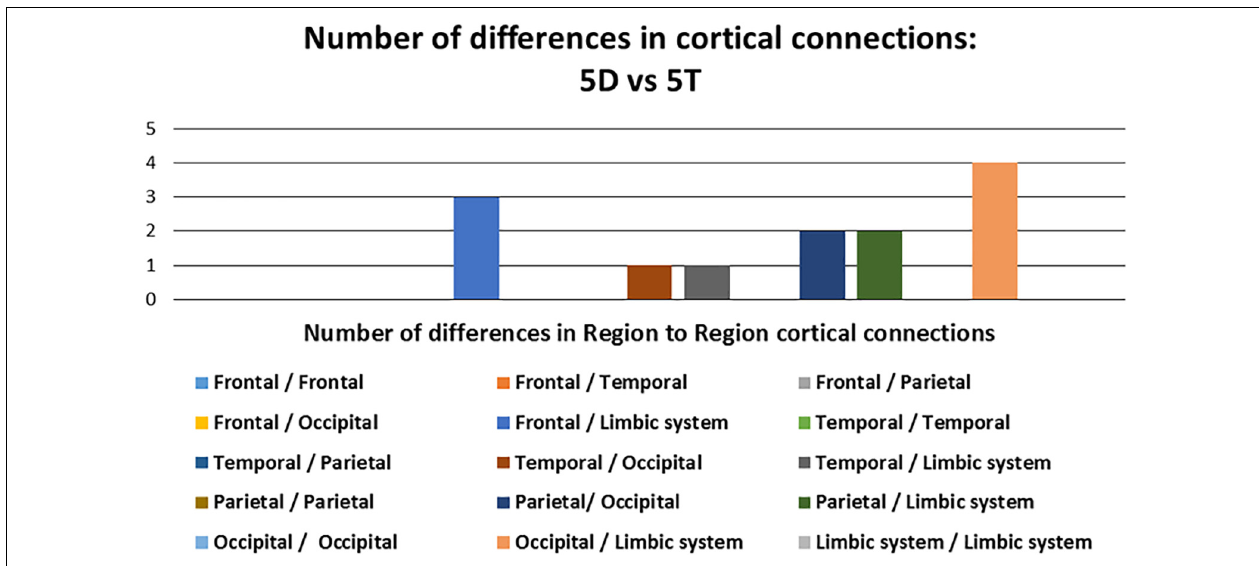
FIGURE 4 | Number of differences in neural connections: Comparison between five single-digit calculation (5D) versus five-note transposing